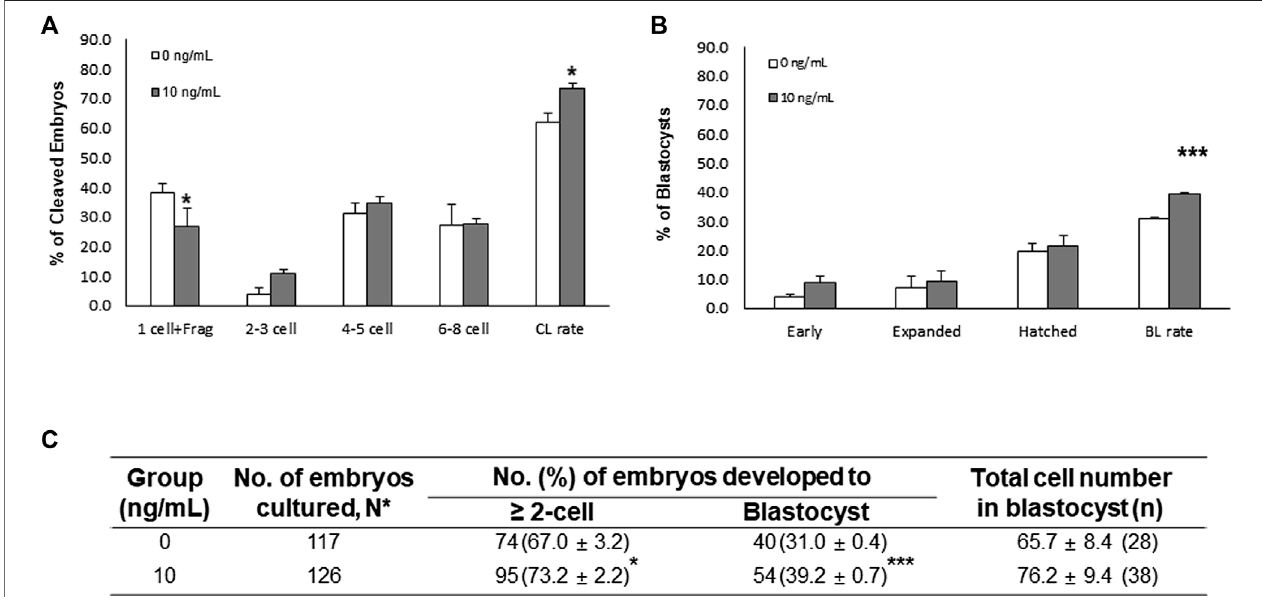
FIGURE 5 | Effects of neurotrophin-4 (NT-4) treatment during in vitro maturation (IVM) on embryonic development after in vitro fertilization (IVF). (A) cleavage (CL) patternand (B) blastocyst(BL)formationpatternofIVFembryos.* p < 0.05and*** p < 0.001(Student ’ st-test).TheCLratewasmeasuredonday2,andtheBLformation rate was evaluated on day 7 of culture. Data are presented as the mean ± SEM from three replicate experiments (C) Summary of embryonic development after IVF.